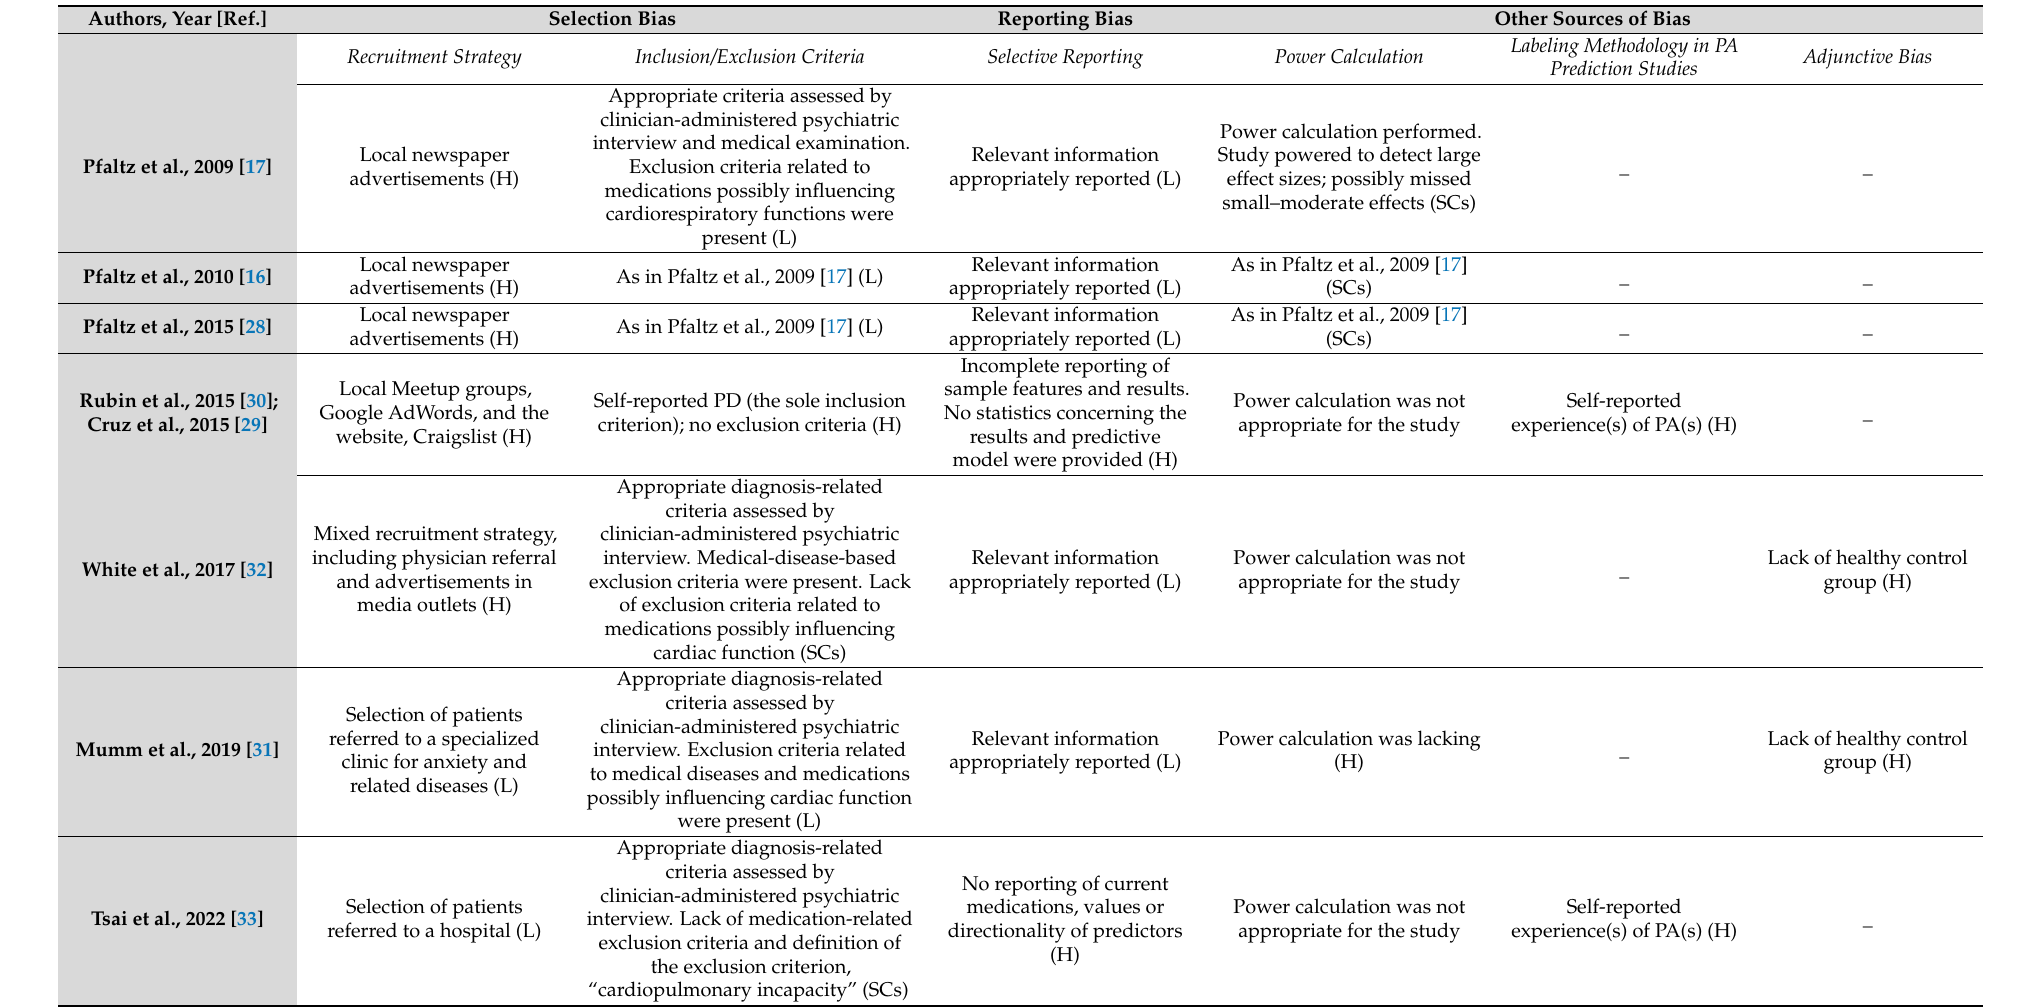
Table 2. Details of the risk of bias in the individual selected